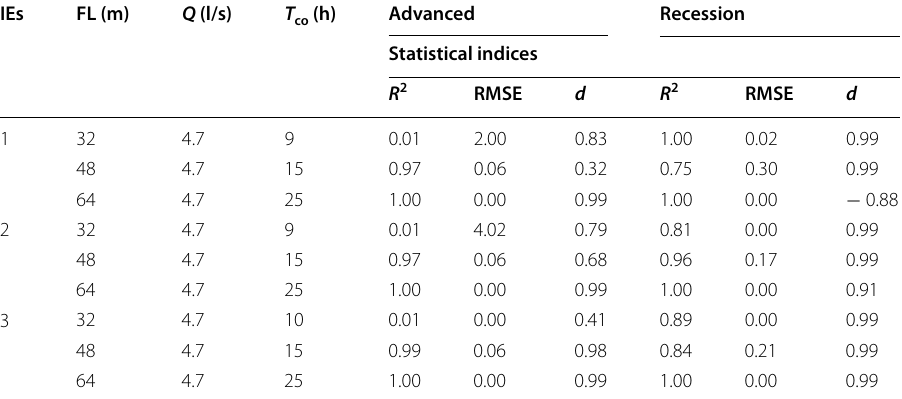
R 2 coefficient of determination, RMSE root mean square error, d index of agreement